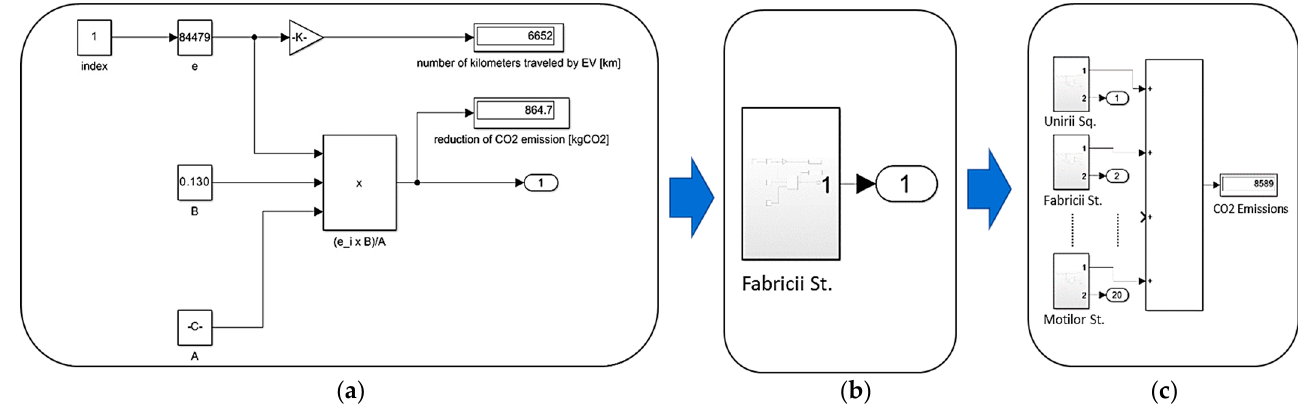
Figure 14. Reduction of CO 2 emissions and the number of km traveled with EVs: ( a ) for the loads made at the charging station on Fabricii Street, ( b ) the Simulink subsystem for Fabricii street, ( c ) the full system used to calculate the CO 2 reduction from all charging stations in Cluj-Napoca.